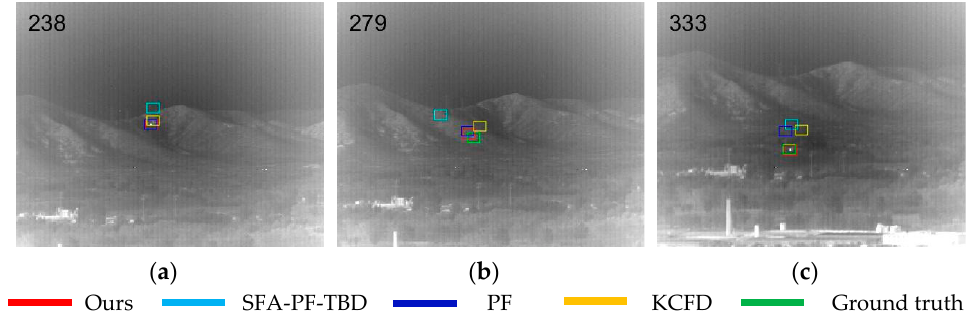
Figure 6. Tracking results of four methods for data20. ( a ) Results at frame 238; ( b ) results at frame 279; ( c ) results at frame 333.